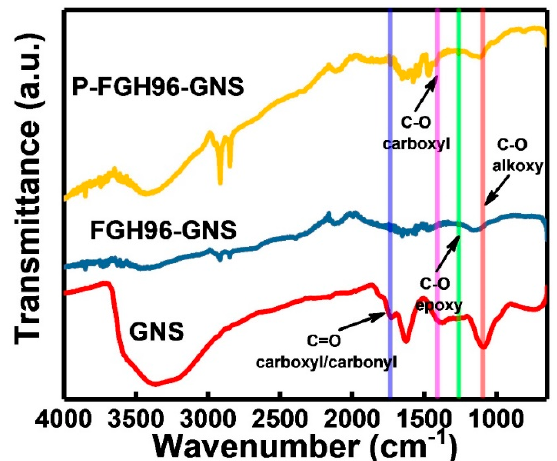
Figure 6. FTIR spectra of the pristine GNSs, FGH96-GNSs powder, and P-FGH96-GNSs powder.